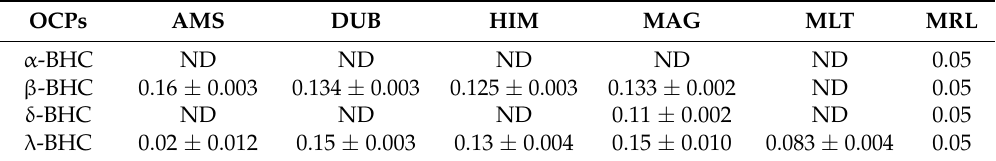
Table 5. Mean concentration of hexachloro cyclohexane (mg/kg) isomers in Malt